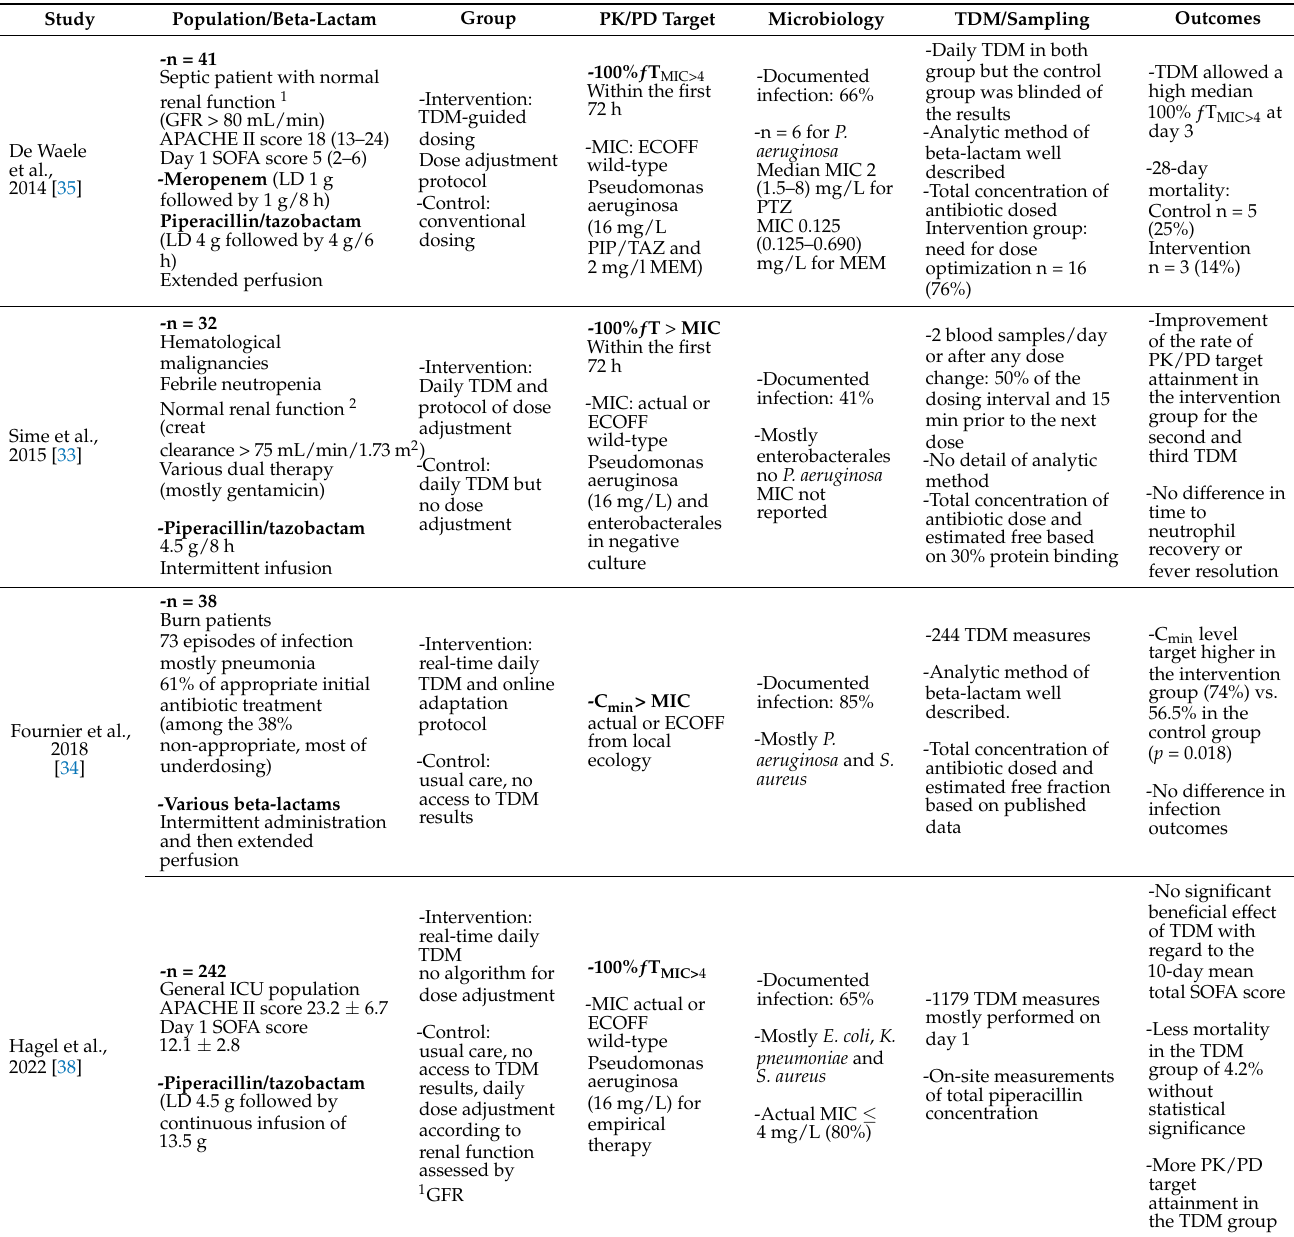
Table 2. Characteristics of the four most recent PK/PD target randomized control